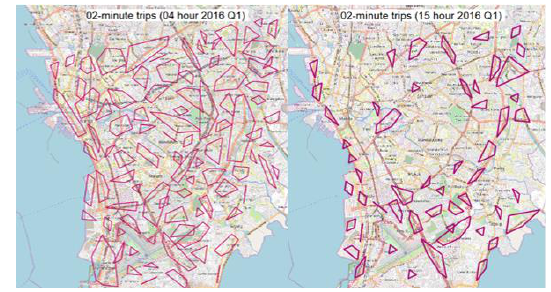
Figure 7. Comparing the 2-minute trips for 04 hour of the day (left) and 15 hour of the day (right)